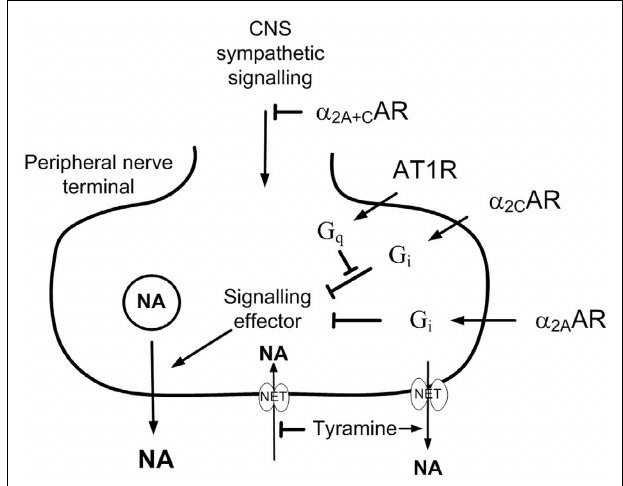
FIGURE 1 |The effect of presynaptic α 2C AR andAT 1 R on norepinephrine release . AT 1 R-G q -signaling stimulates norepinephrine release by interfering with the down-stream signaling of G i (Cox et al., 2000).The AT 1 R/ α 2 AR interaction involved only the α 2C - and not the α 2A -subtype (Trendelenburg et al., 2003a).The present results show that α 2C AR-stimulation or